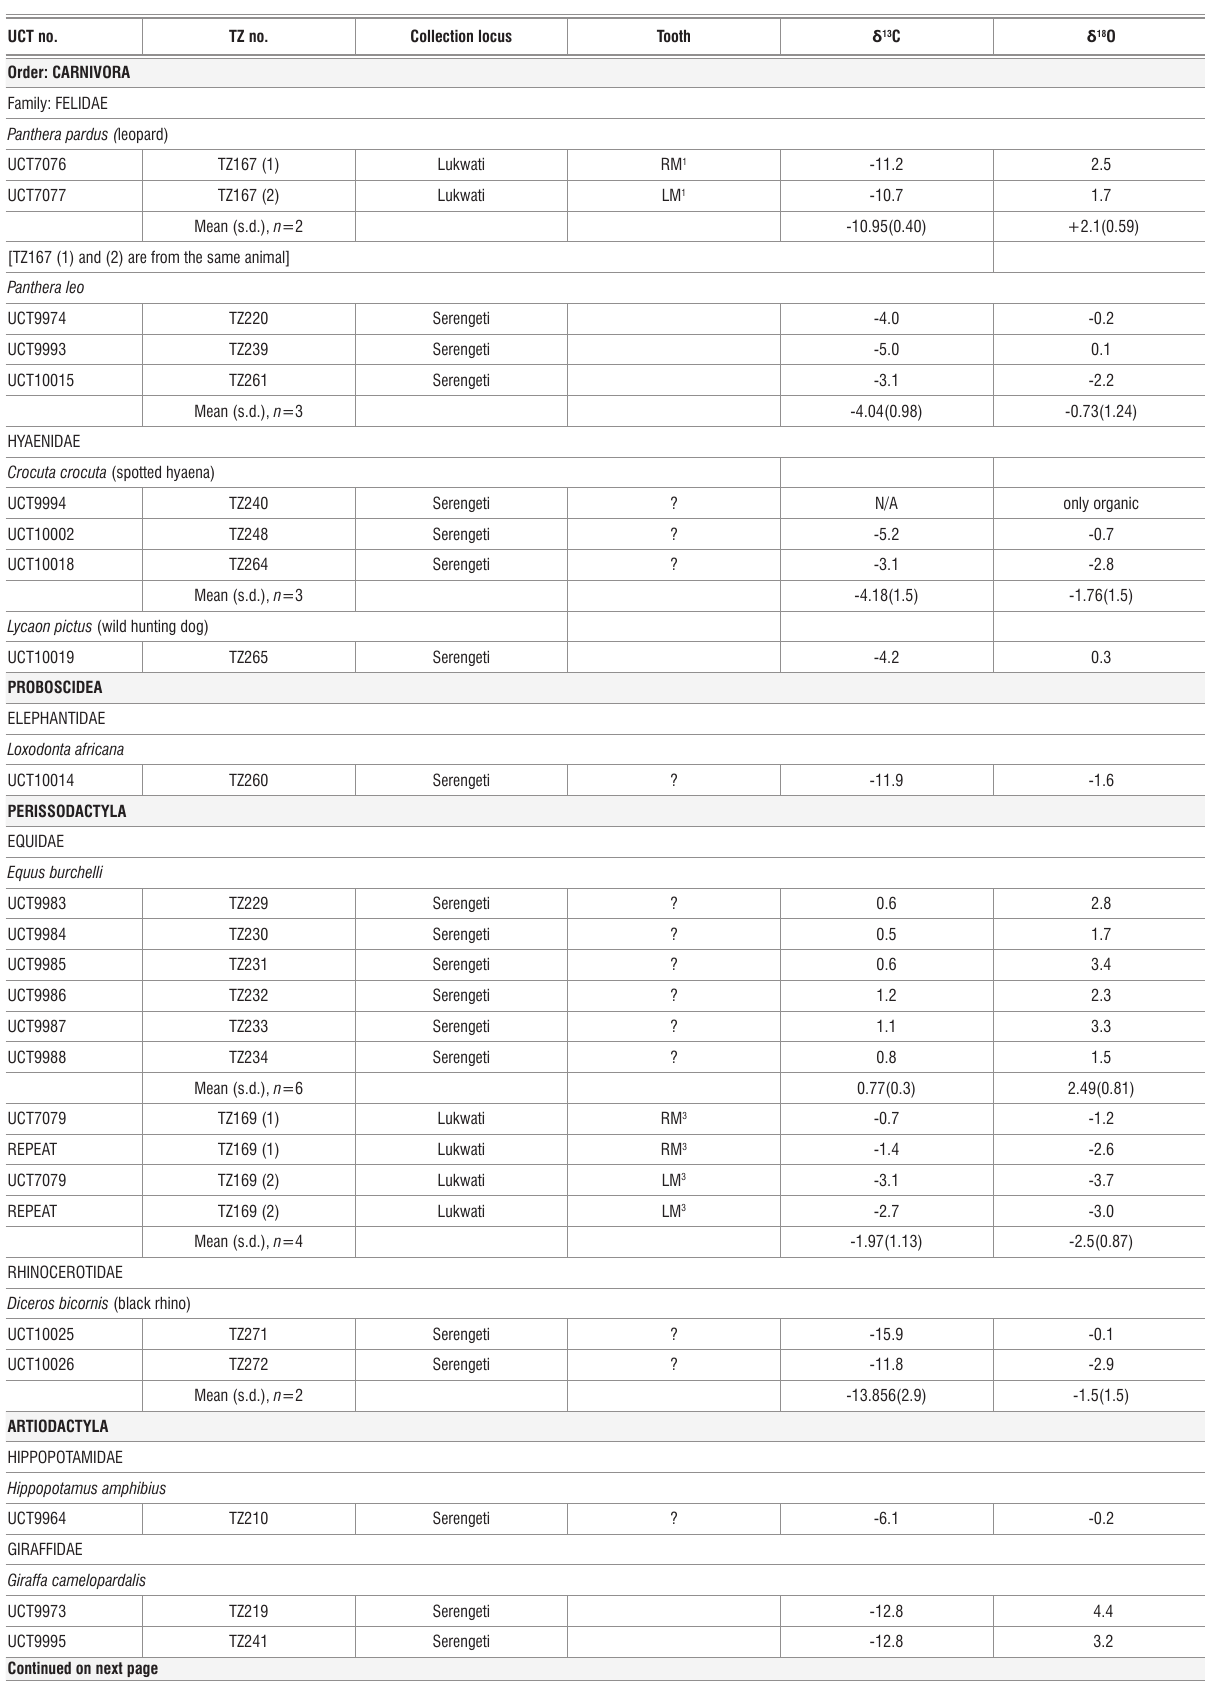
Table 3: Carbon and oxygen stable isotope ratios in tooth enamel of modern fauna from Serengeti National Park and Maswa Game Reserve (southwest Serengeti), Lobo (northeast Serengeti), Selous Game Reserve (southeast Tanzania), Ugalla and Lukwati (southwest Tanzania) UCT no. TZ no. Collection locus Tooth δ 13 C δ 18